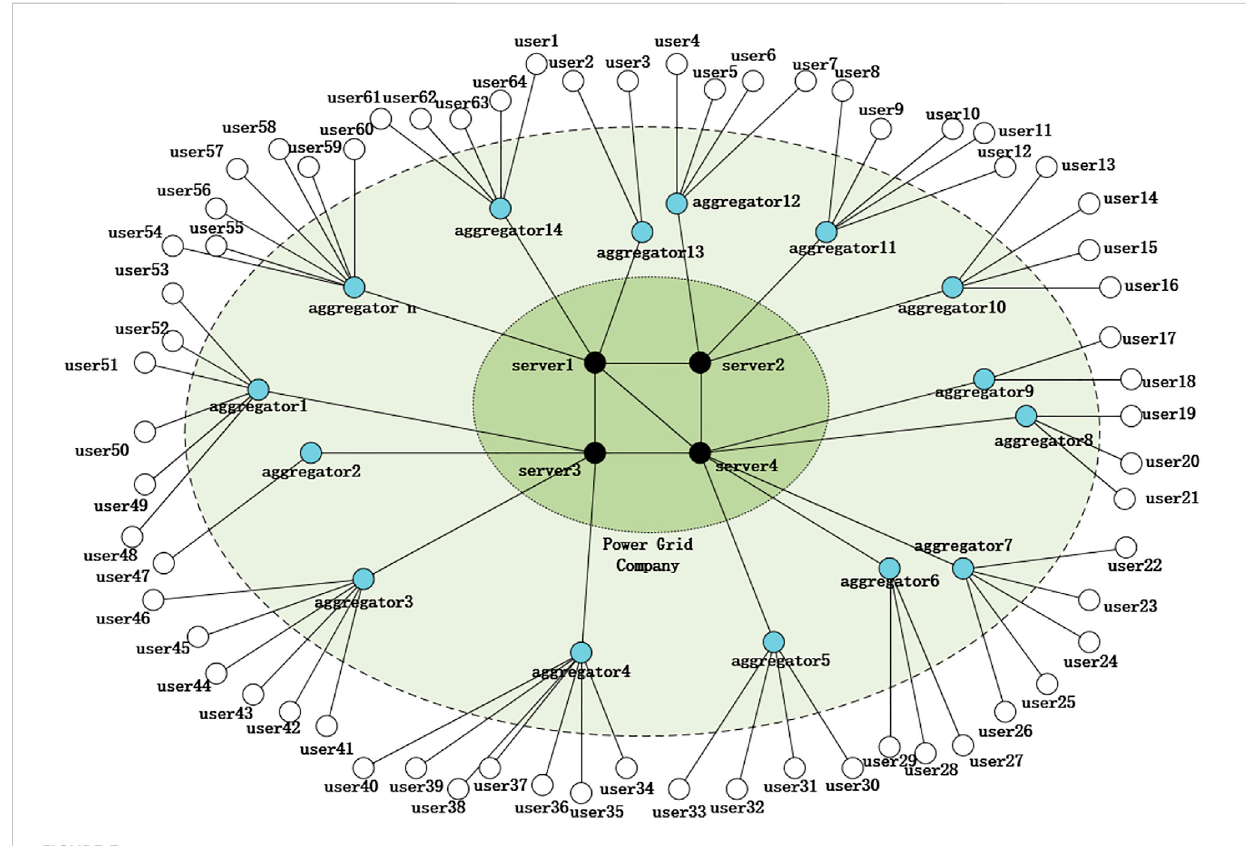
FIGURE 3 Complex network model of user electricity